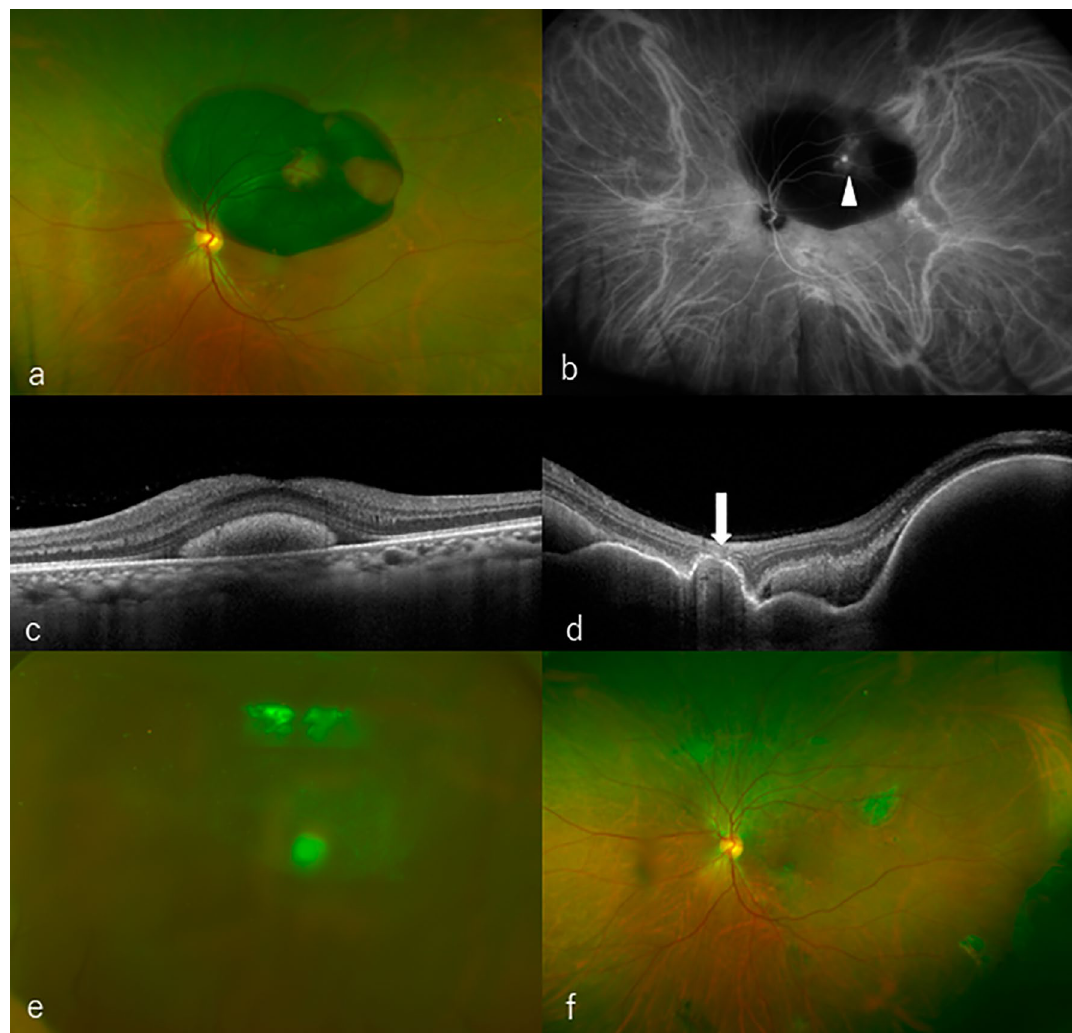
Figure 1. ( a ) A 63-years-old man presented with visual loss in his left eye (BCVA 20/20). Funduscopic examination shows a SMH including the macula. ( b ) Indocyanine green angiography (ICGA) shows blockage due to the hemorrhage and the hyperfluorescent lesions (arrowhead). ( c ) A baseline OCT image shows the SMH. ( d ) SD-OCT corresponding to the hyperfluorescent lesions in ICGA shows the protrusion of polyps (arrow) with the SMH and a hemorrhagic PED. He was diagnosed with PCV and started IVBr treatment. ( e ) One month after the initial treatment, VH developed and his BCVA decreased to 20/300. Surgical treatment was performed. ( f ) Fundus photography at 12 months shows that the SMH improved although his BCVA decreases to